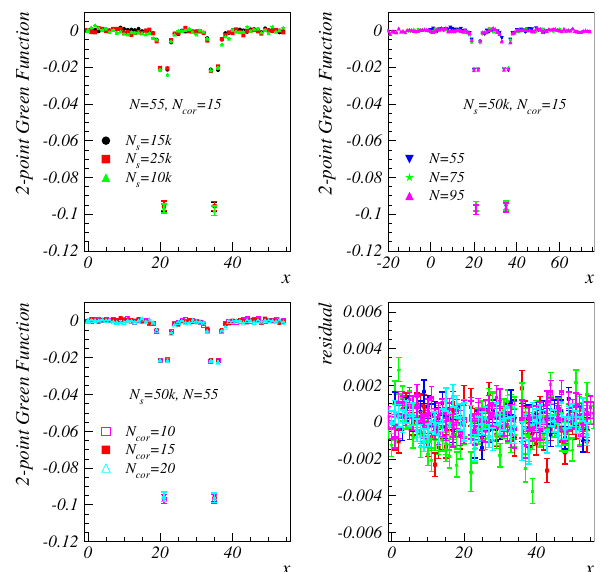
Fig. 16 Potentials for various values of parameters used in the simula- tion. The g 2 φ 4 Lagrangian, Eq. (1), is used with g 2 = 0 . 5. The system size, N , the decorrelation parameter, N cor , and the statistics, N s , are varied. In the bottom right panel , the residuals between the results and the effective Yukawa behavior are shown. The vertical axis span is the same as for the three first panels and magnified by a factor 10 for the bottom right panel showing the residuals